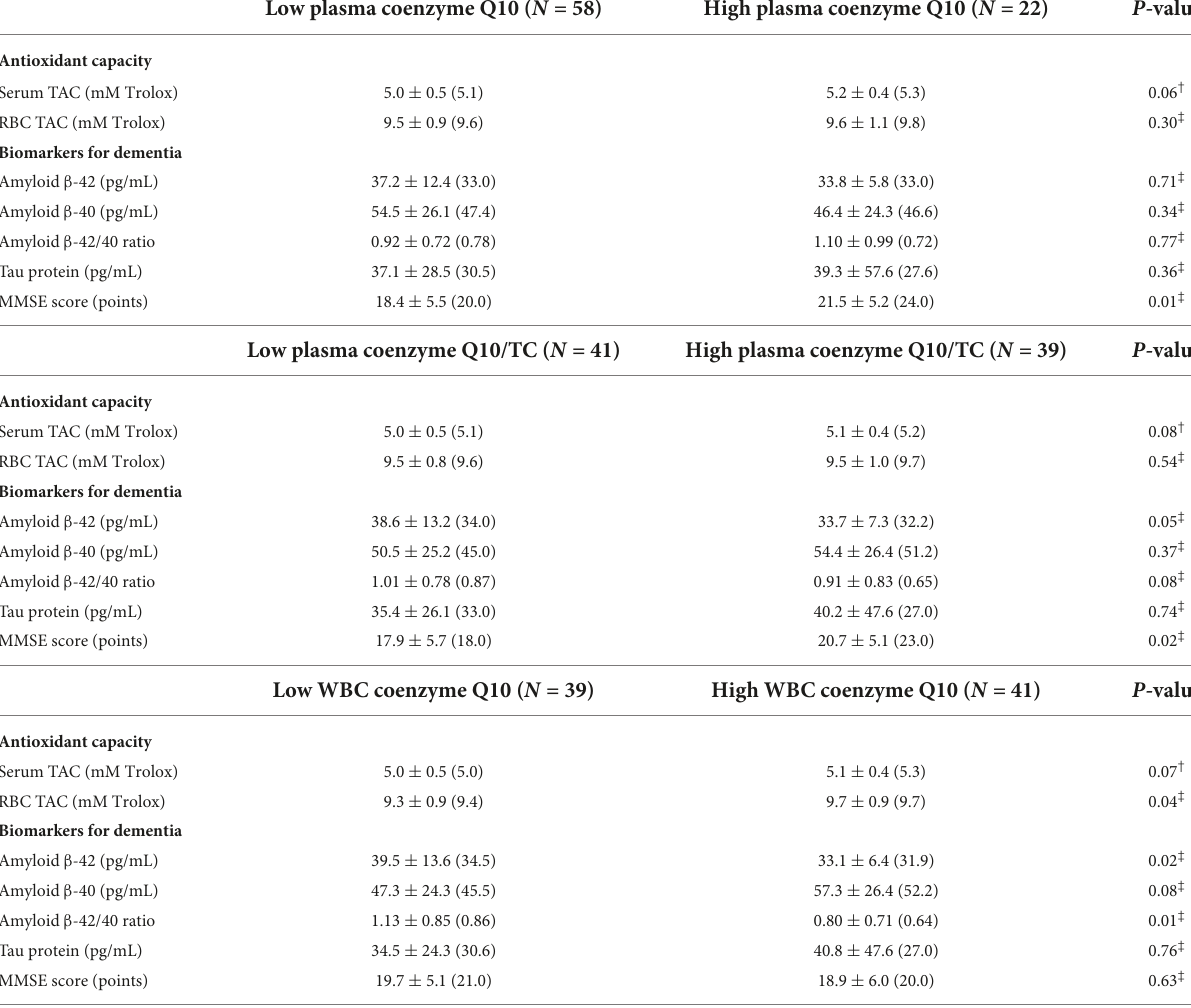
p < 0.05, Figure 2A ; plasma coenzyme Q10/TC, r = 0.23, p = 0.04, Figure 2C ; WBC coenzyme Q10, r = 0.24, p = 0.03, Figure 2E ) and RBC TAC (WBC coenzyme Q10, r = 0.30, p < 0.01, Figure 2F ). These significant correlations also existed in patients with mild dementia ( Figures 2A,E,F